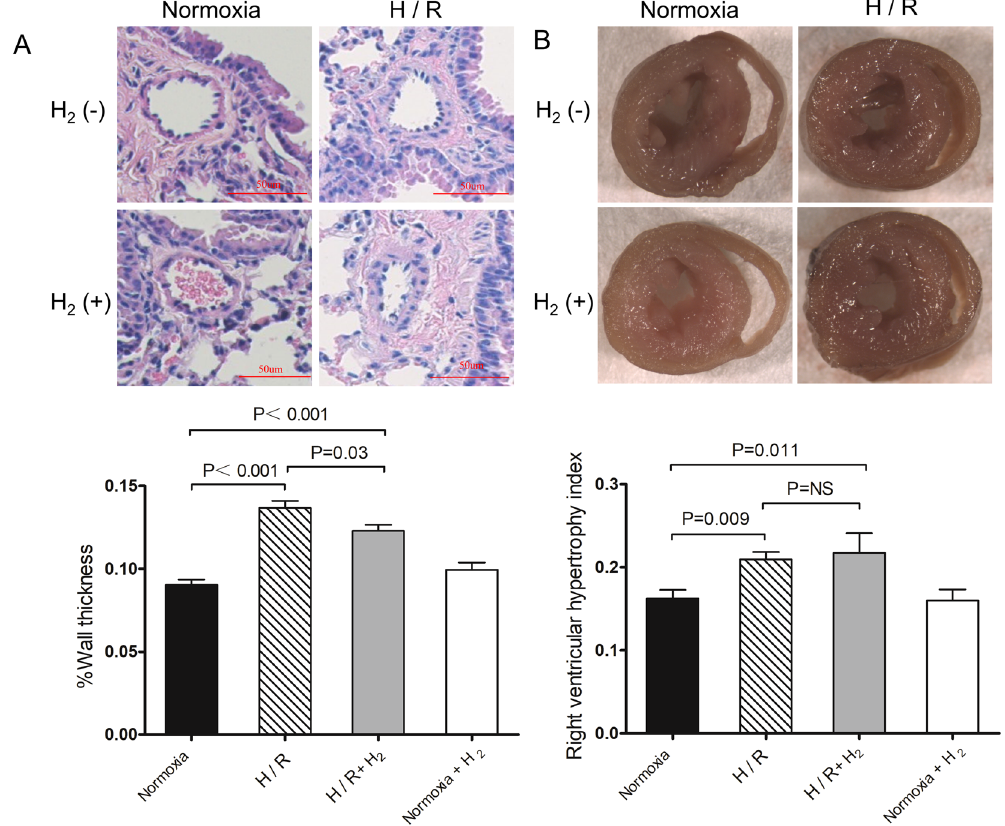
Figure 2. Limited effect of hydrogen on H/R-induced pulmonary artery remolding. Mice were treated as described in Fig. 1 (n = 10 in each group). ( A ) Representative sections stained with hematoxylin-eosin (top) and percentage of wall thickness of pulmonary arterioles in the lungs (bottom). ( B ) Mouse hearts in cross section (top) and right ventricular hypertrophy index (see Methods) (bottom). Data shown are mean ± SEM. ns, not